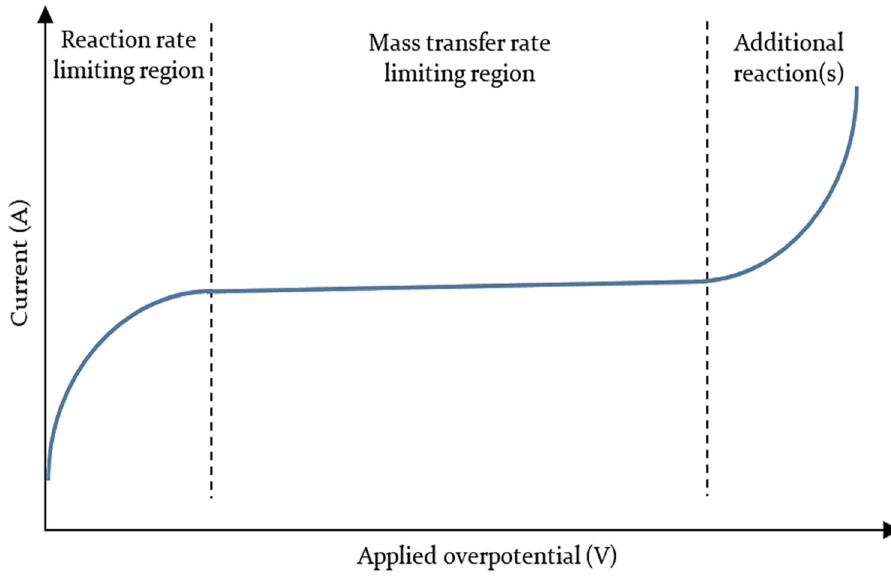
Fig. 2 IV behaviour for an electrochemical system exhib- iting a good limiting-current